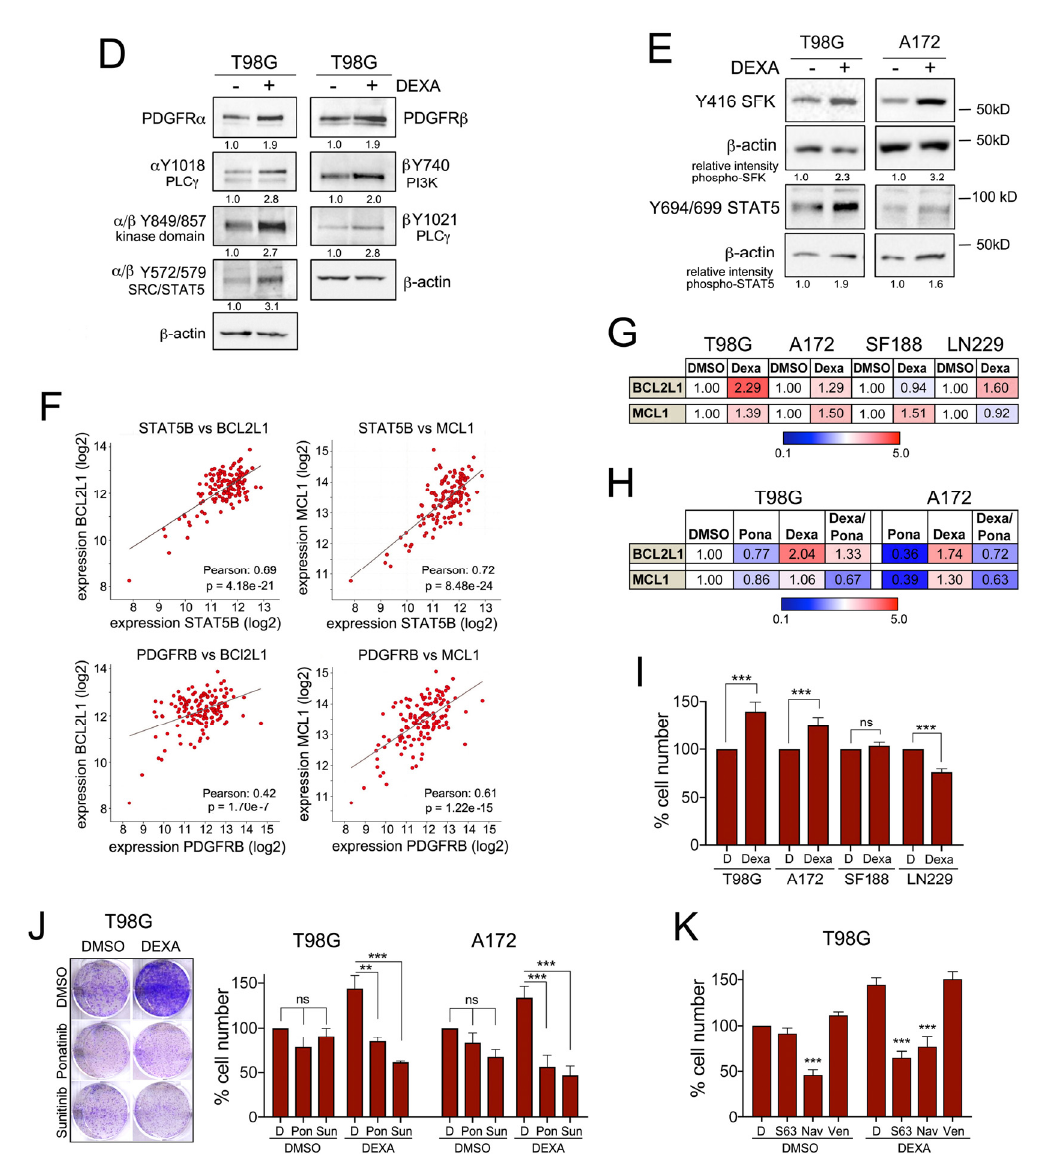
Figure 3. Dexamethasone induces PDGFR mediated survival signalling. ( A ) Functional characteristics of T98G cells treated with 25 µ M DEXA for 18 h revealed by GSEA using GO term and PID gene set collections. ( B ) qRT-PCR analysis for PDGFRA, PDGFRB and PDGFB in the indicated cell lines represented as mean fold change of triplicates treated with DEXA for 18 h relative to DMSO. ( C ) Western blot analysis for PDGFRA and PDGFRB in the indicated cell lines either untreated or treated with DEXA for 18 h. Beta-actin served as loading control. ( D ) Western blot analysis for PDGFRA, PDGFRB and the indicated phospho-specific antibodies in T98G cells either untreated or treated with DEXA for 18 h. The lysate of one experiment was run on several lanes per blot, which were probed in parallel. Beta-actin serves as loading control and representative controls are shown. ( E ) Western blot analysis for phospho-SFK (using a phospho SRC antibody) and phospho-STAT5 in the indicated cell lines either untreated or treated with DEXA for 18 h. Beta-actin served as loading control. ( F ) Co-expression analysis of the indicated genes from the TCGA Glioblastoma dataset. ( G ) qRT-PCR analysis for BCL2L1 and MCL1 in the indicated cell lines represented as mean fold change of triplicates treated with DEXA for 18 h relative to DMSO. ( H ) qRT-PCR analysis as in ( G ). Cells were treated with DEXA in the absence or presence of 200 nM ponatinib for 18 h. ( I ) Quantification of the relative cell number of the indicated cell lines grown in the absence or presence of 25 µ M DEXA. Data represent the mean ± SEM ( n ≥ 3). ( J ) Quantification of the relative cell number of the indicated cell lines grown with or without 25 µ M DEXA in the absence or presence of 25 nM or 100 nM ponatinib (Pon) or 1 µ M or 3 µ M sunitinib (Sun). Data represent mean ± SEM ( n ≥ 3). ( K ) Quantification of the relative cell number of T98G cells grown with or without 25 µ M DEXA in the absence or presence of 5 µ M S63845 (S63), 1 µ M navitoclax (Nav) or 5 µ M venetoclax (Ven). Data represent mean ± SEM ( n ≥ 3). ** p < 0.01, *** p <